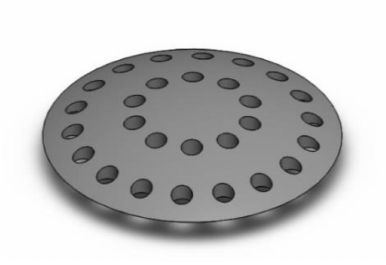
Figure 3. Metatarsal button as seen from the top.